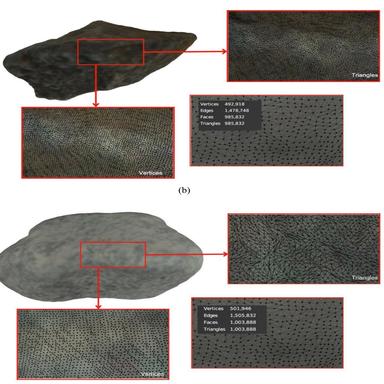
Mesh surface of the ballast 3D particle: (a) fresh ballast and (b) used ballast.